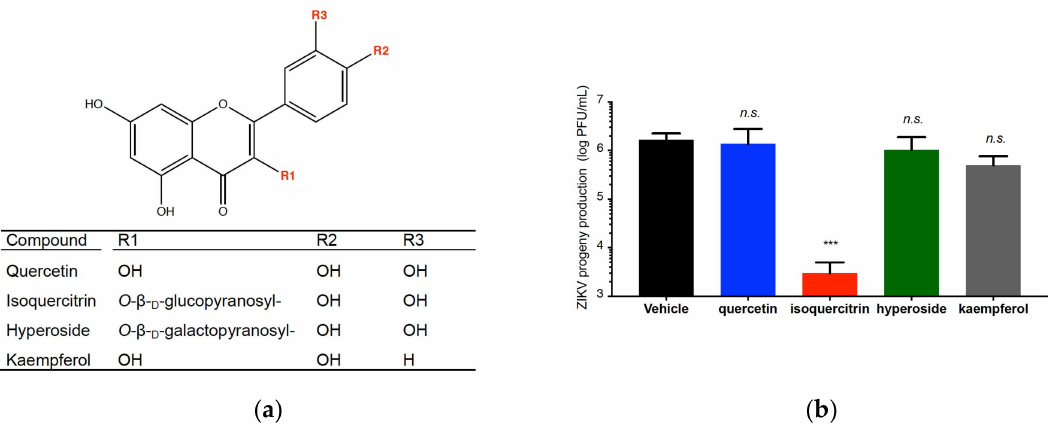
Figure 6. ZIKV sensitivity to the selected flavonoids. In ( a ), chemical structure of quercetin, isoquercitrin, hyperoside and kaempferol. In ( b ), A549 cells were infected with ZIKV MR766 MC in presence of 100 µ M of each flavonoid and virus progeny production was determined at 24 h p.i. Data represent the means ± SD of four independent experiments performed in